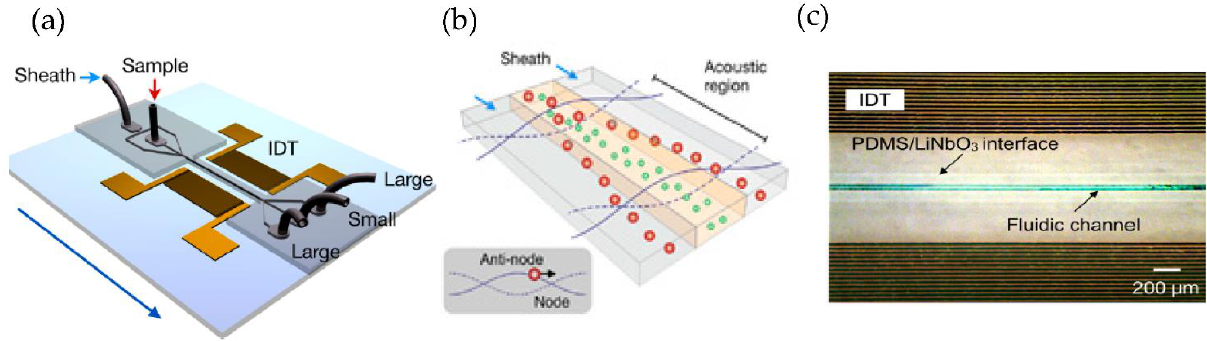
Figure 12. Acoustic nanofilter for label-separation of microvesicles (MVs). ( a ) Device schematic. ( b ) Filter operation indicates MVs transported to the acoustic pressure region (inset). ( c ) SEM image of the prototype device. (Adapted with permission from Lee K. et al. [77]. Copyright 2015, American Chemical Society).